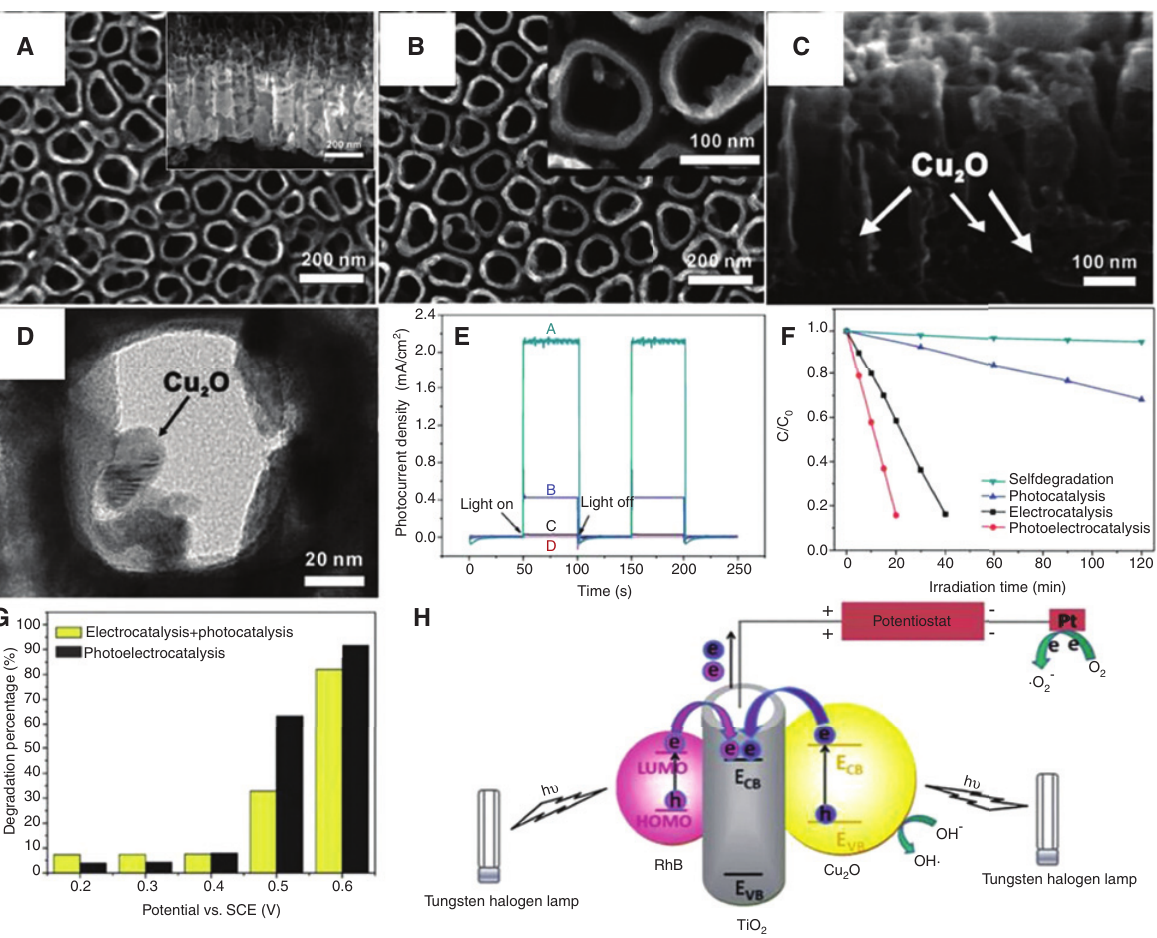
NTAs (A) and Cu O/TiO NTAs (B, C). TEM image (D) of Cu O/TiO NTAs. Photoresponse (E) of Cu O/TiO NTAs Figure 23: SEM image of TiO 2 2 2 2 2 2 2 with (curve A) or without (curve C) a bias potential of 0.5 V (vs. SCE) and TiO NTAs with (curve B) or without (curve D) a bias potential of 2 0.5 V (versus SCE) under visible light irradiation. (F) Comparison of photocatalytic, electrocatalytic, and photoelectrocatalytic degrada- tion of RhB under visible light irradiation for Cu O/TiO NTAs. (G) Comparison of RhB degradation efficiency using Cu O/TiO NTAs in the 2 2 2 2 process of photoelectrocatalysis (right) and with the sum of photocatalysis and electrolysis (left). (H) Schematic illustration of photoelec- trocatalytic degradation of RhB under visible light irradiation. Reproduced from Ref. [235] with permission. Copyright Royal Society of Chemistry journals. [Figure caption was corrected after online publication February 10, 2016. Text before amendment: […] TEM image of Cu O/TiO NTAs (D). 2 2 Photoresponse of Cu O/TiO NTAs with (A) or without (C) a bias potential of 0.5 V (vs. SCE) and TiO NTAs with (B) or without (D) a bias 2 2 2 potential of 0.5 V (versus SCE) under visible light irradiation. Comparison of photocatalytic, electrocatalytic, and photoelectrocatalytic degradation of RhB under visible light irradiation for Cu O/TiO NTAs (F). Comparison of RhB degradation efficiency using Cu O/TiO NTAs 2 2 2 2 in the process of photoelectrocatalysis (right) and with the sum of photocatalysis and electrolysis (left) (G). Schematic illustration of pho- toelectrocatalytic degradation of RhB under visible light irradiation (H).